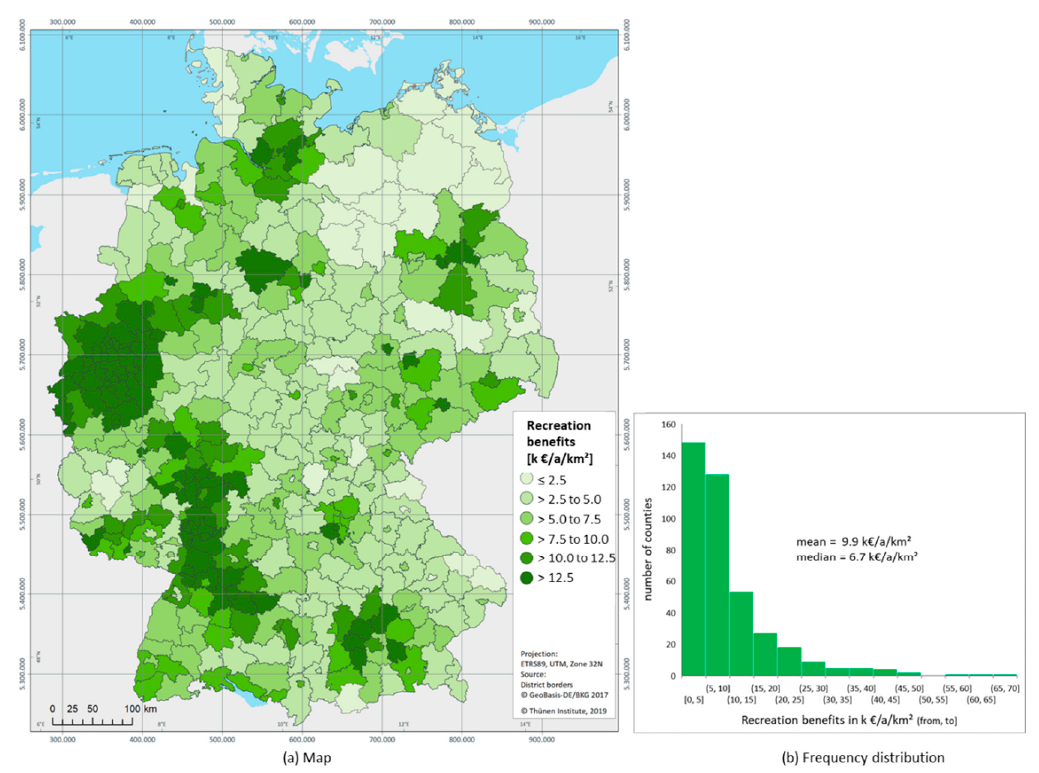
Figure 7. Annual recreation benefits for local residents in the counties.